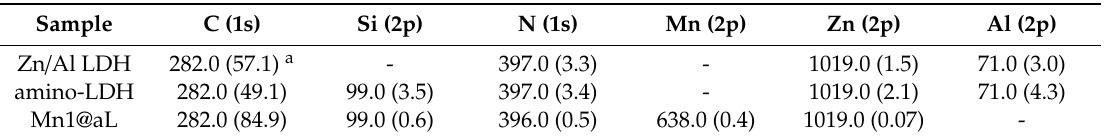
Table 3. Binding energies and surface atomic compositions of C, N, Mn, Zn, and Al species in synthetic